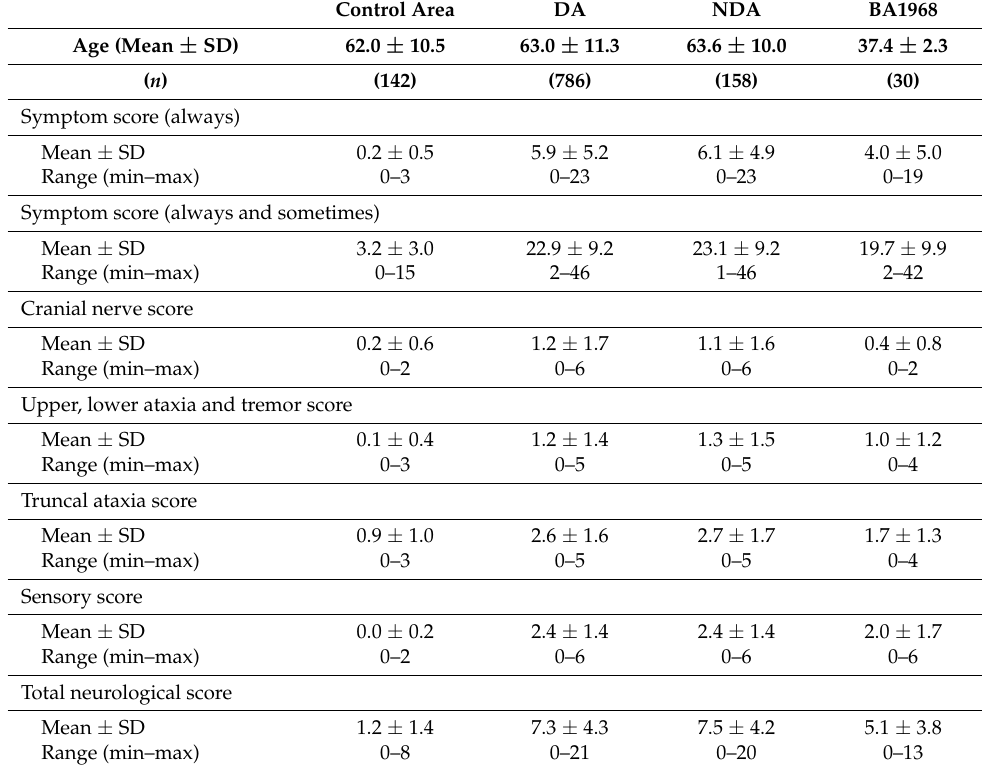
Table 10. Score of signs and symptoms in DA, NDA, and BA1968 ( n =